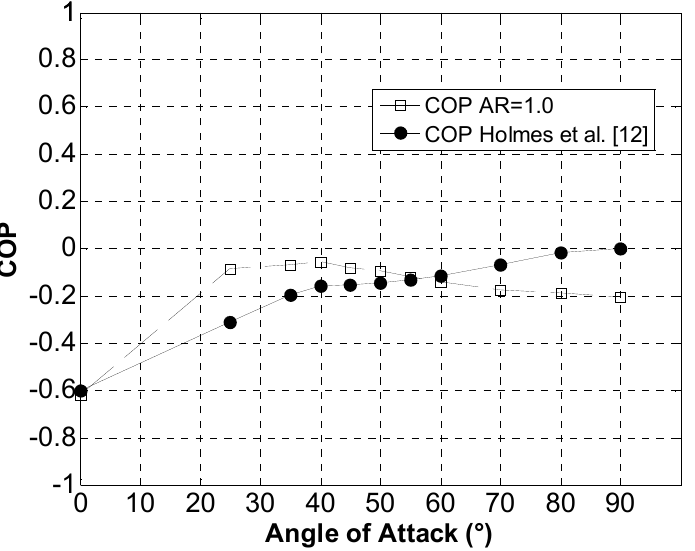
Figure 7. Free stream CoP for AR = 1.0 compared with Equation (5) from Holmes et al. [12].